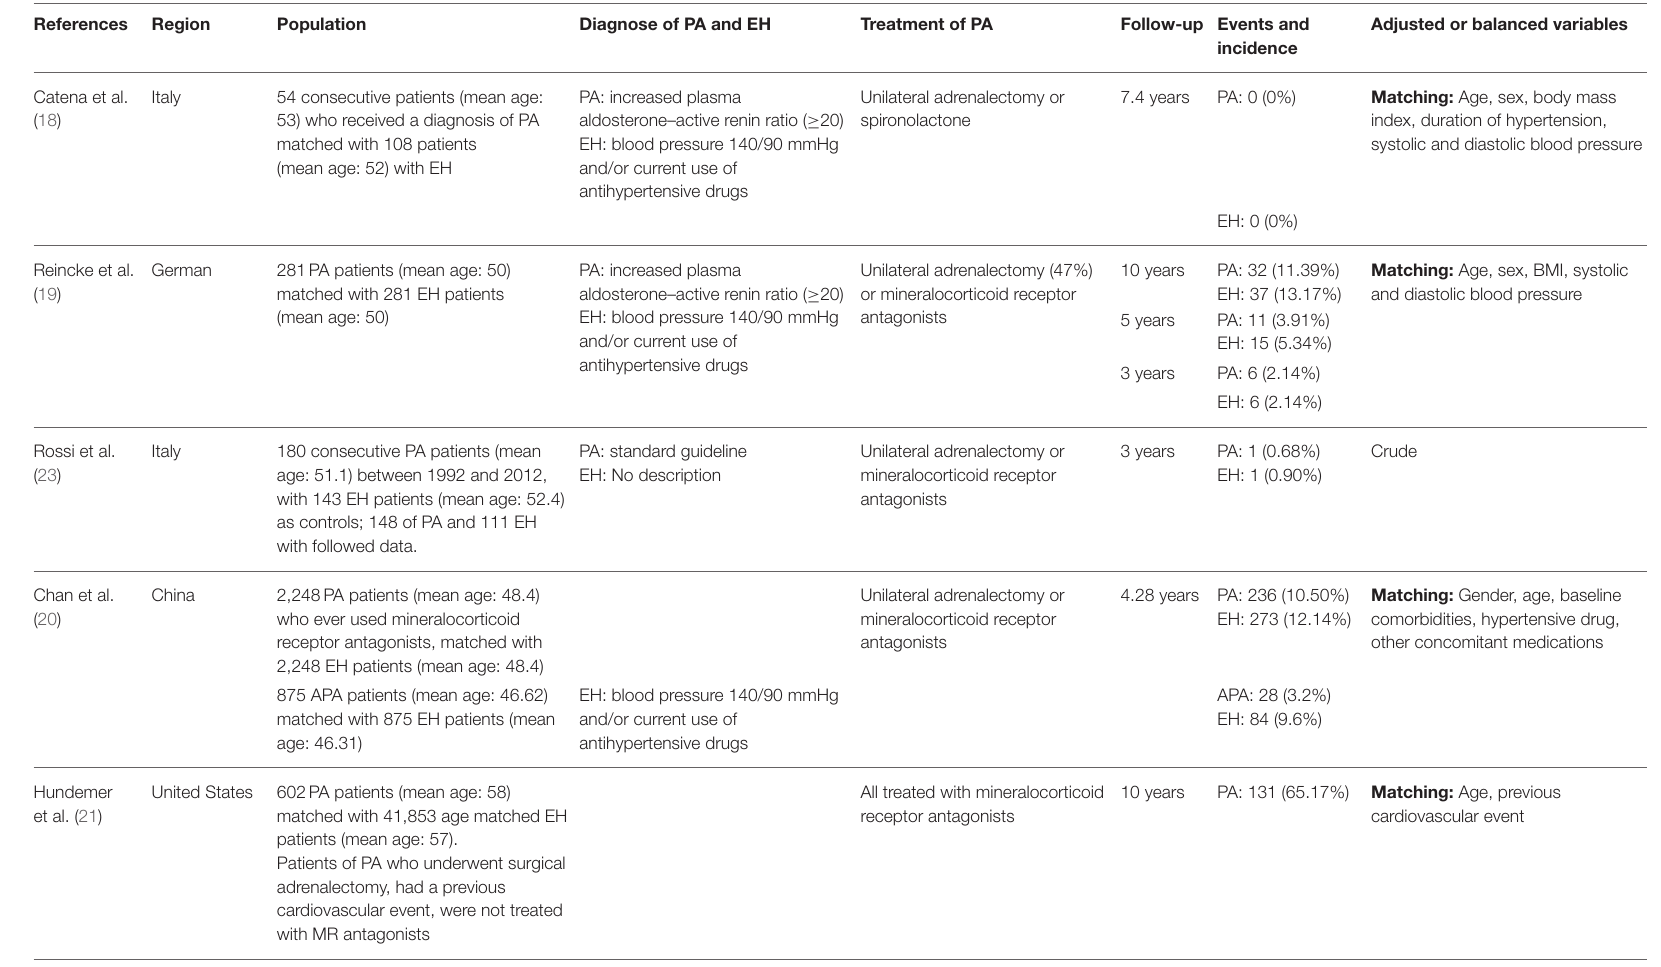
TABLE 1 | Baseline characteristics of include